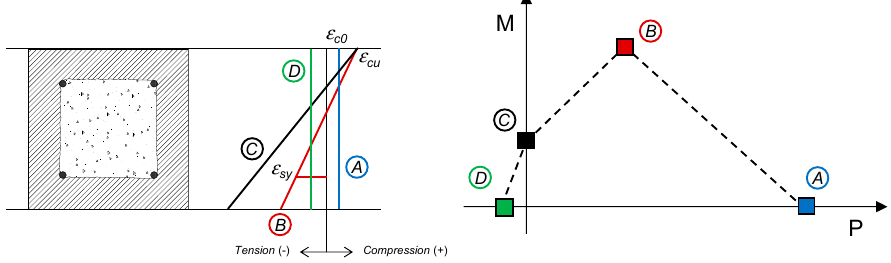
Figure 16. Strain distribution at failure for determining the P–M interaction domain.